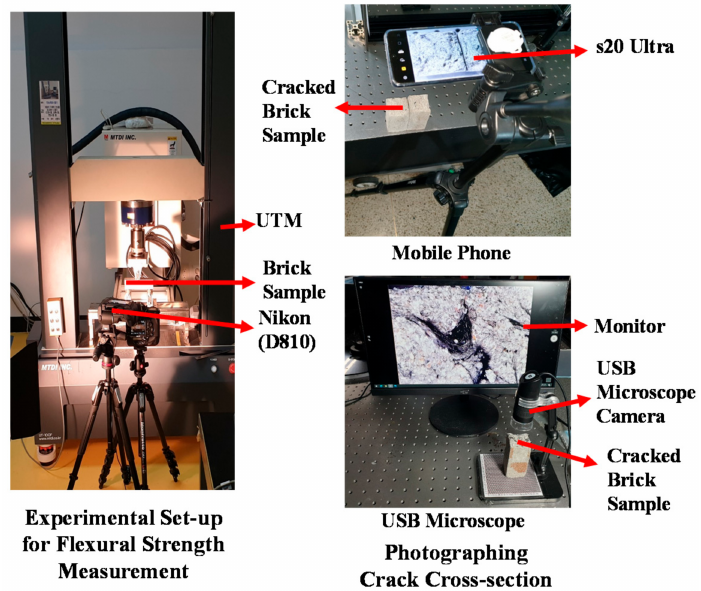
Figure 1. Experimental set-up. Each camera is set to the single frame